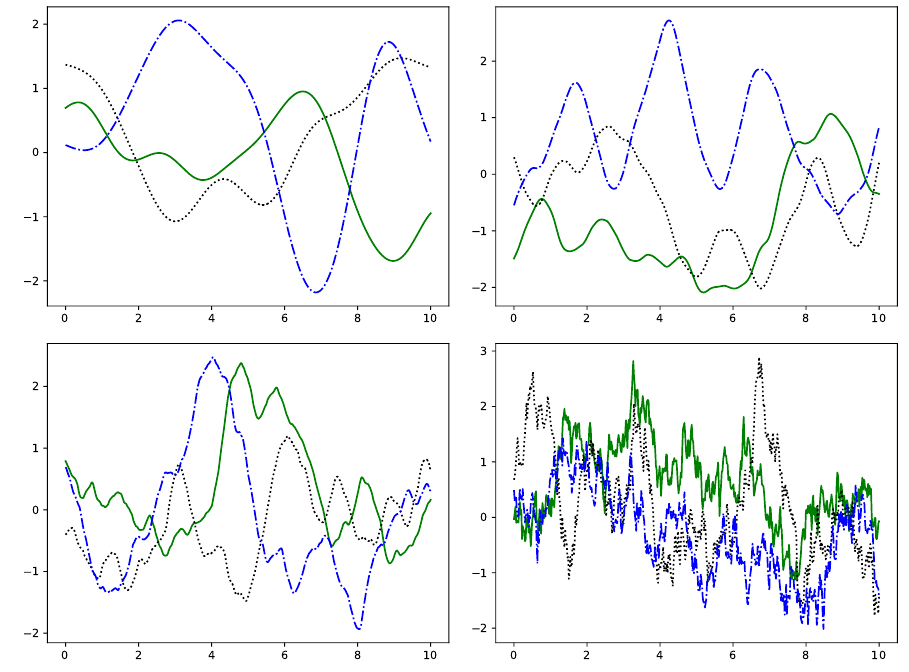
Figure 1. Samples from GPs with different kernels: squared exponential ( upper left ), Matérn 5/2 ( upper right ), Matérn 3/2 ( lower left ) and 1-exponential ( lower right ). All samples have length-scale parameter (cid:96) = 1.